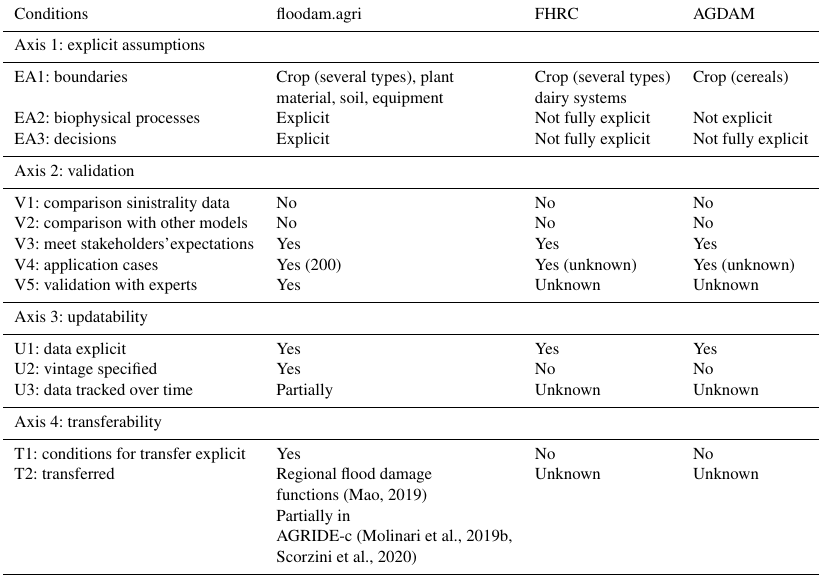
Table C1. Illustration of the use of the methodological framework to describe and compare three process-based models.